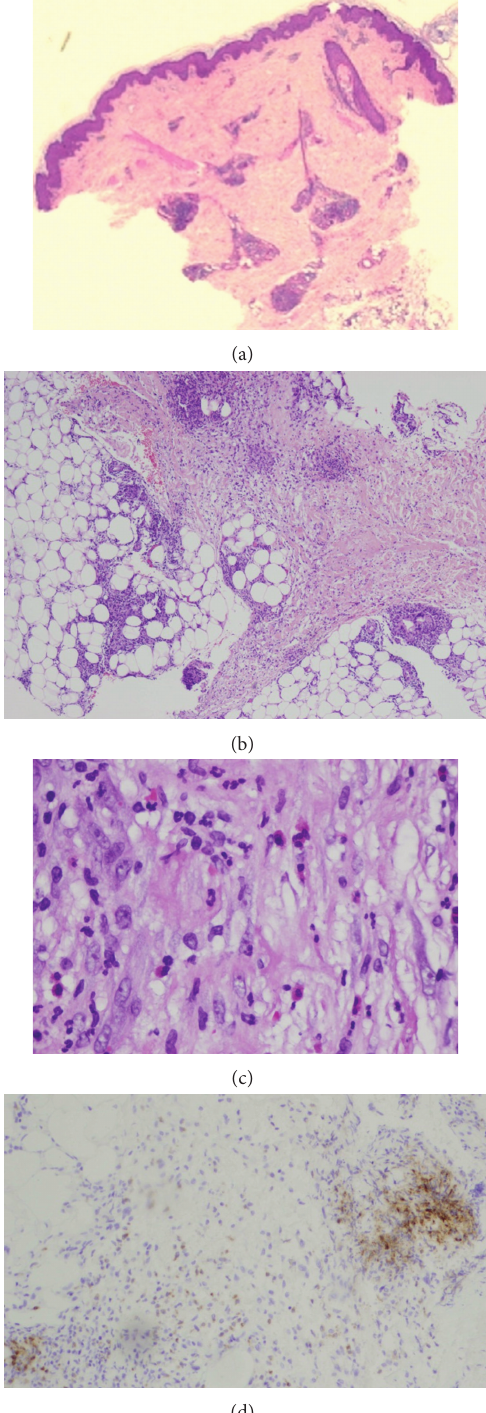
(d) Figure 2: (a) Normal epidermis and dermis. Inflammatory infiltrate affecting exclusively the adipose tissue (hematoxylin-eosin, original magnification × 2). (b) Inflammatory infiltrate in the subcutaneous tissue, predominating in the septa, but also in the fat lobules (hematoxylin-eosin, original magnification × 10). (c) Infiltrate of polymorphonuclear cells, eosinophils, and large, mononuclear cells with histiocytoid appearance (hematoxylin-eosin, original magnifi- cation × 20). (d) Immunoreactivity for myeloperoxidase in most of the cells of the inflammatory